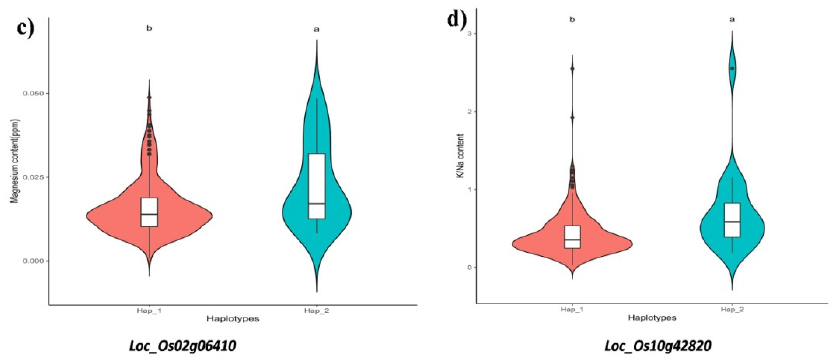
Figure 1. Violin plots indicating the significant haplotypes of candidate genes for ( a ) K + content, ( b ) Ca 2+ content, ( c ) Mg 2+ content and ( d ) K + /Na + (x-axis=haplotypes; y-axis= trait value). Each box plot with in the violin plot represents minimum, lower quartile, median, upper quartile, and maximum values. Different letters above the violin plots indicate statistically significant differences for the respective haplotypes, at a significance level of p < 0.05 (Duncan test).